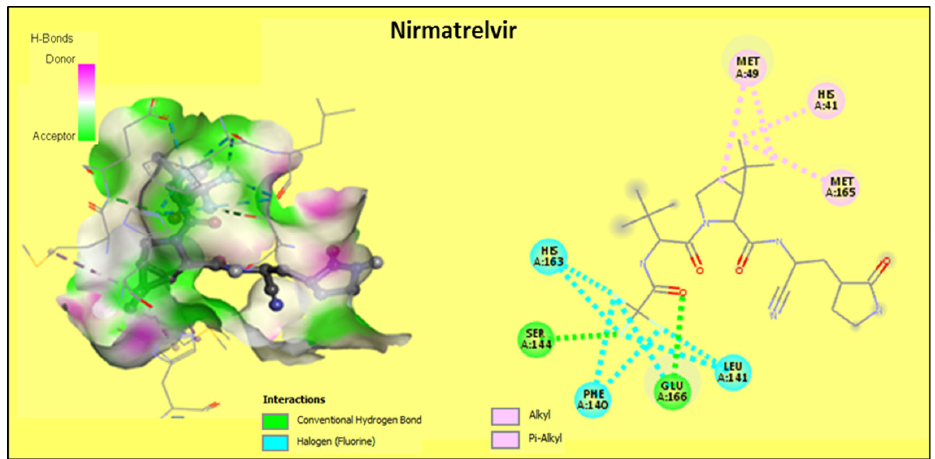
Figure 6. Representation of the 3D structure of the docked nirmatrelvir bound to the pocket region of SARS ‐ CoV ‐ 2 M pro with the hydrogen bond ( left ) and the corresponding 2D diagram of the interactions ( right ).